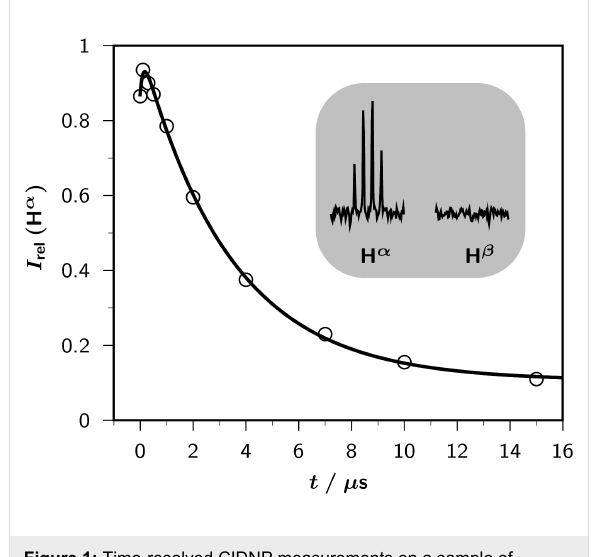
Figure 1: Time-resolved CIDNP measurements on a sample of 5 × 10 − 3 M DES in acetonitrile- d 3 sensitized by 2 × 10 − 4 M TPP + ; temperature, 278 K.The main plot shows the relative CIDNP inten- sities (integrals) I rel ( H α ) of the α protons of the starting sulfide as func- tions of the delay t between the laser flash (wavelength, 308 nm) and the NMR observation pulse (width, 1 μ s; tip angle, 22.5°).The fit func- tion is given by Equation 4, in conjunction with Equation 5 and Equa- tion 6. Best-fit kinetic parameters: k 0 , 8.80 × 10 6 s − 1 , corresponding to a quenching rate constant of 1.8 × 10 9 M − 1 s − 1 ; k ex , 5.37 × 10 7 M − 1 s − 1 ; T 1 , 36.5 μ s.The inset displays the actual CIDNP signals of the α and β protons of DES ( H α , 2.51 ppm; H β , 1.20 ppm) at a delay of 0 μ s. Further explanation, see